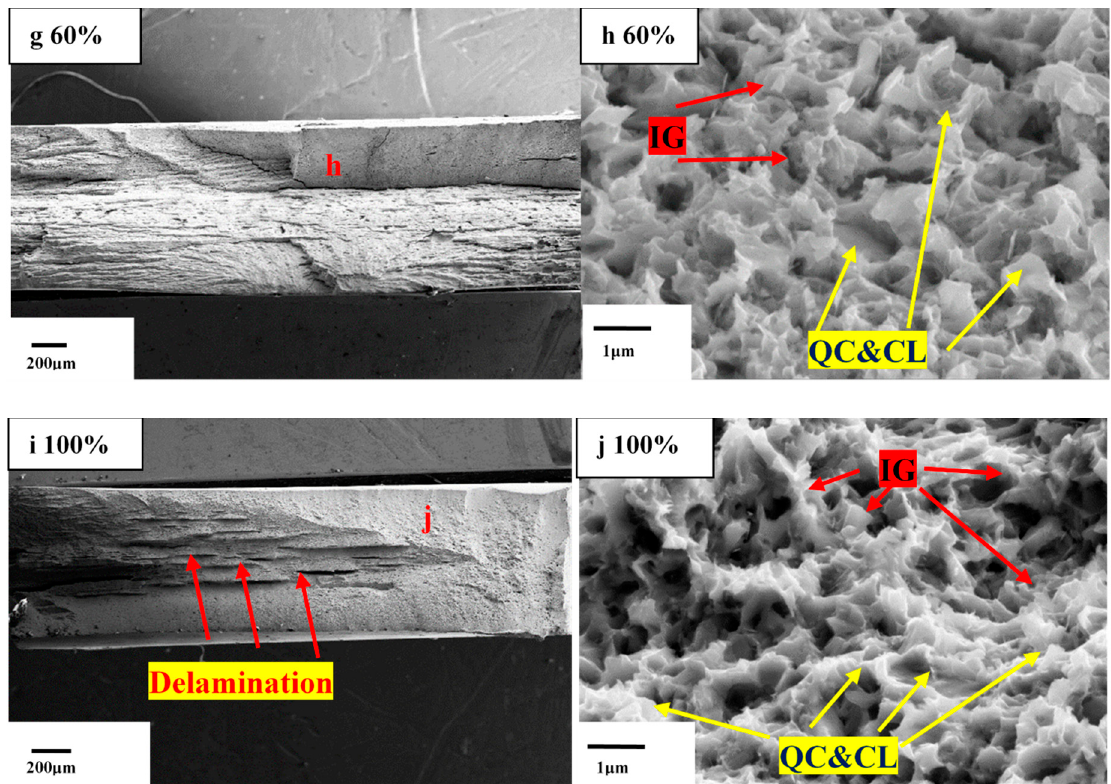
Figure 10. Fracture surface of M10B after SSRTT under different RH conditions with different strain rates: ( a, b ) in air at 10 − 4 s − 1 ; ( c, d ) in 60% RH at 10 − 4 s − 1 ; ( e, f ) in 100% RH 10 − 4 s − 1 ; ( g, h ) in 60% RH at 10 − 6 s − 1 ; ( i, j ) in 100% RH at 10 − 6 s − 1 .